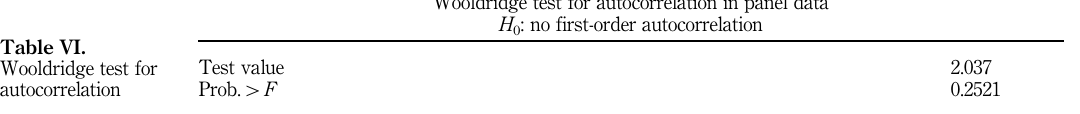
Table VI. Wooldridge test for